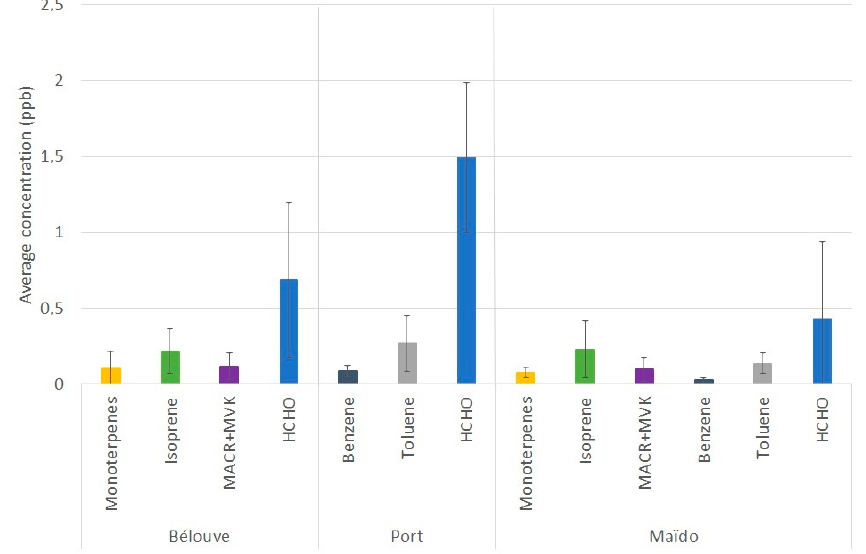
Figure 3. Partitioning of the average concentrations of the main VOCs in ppbv (±1 σ ) measured in Bélouve forest (from 25 April to 2 May 2018) and Le Port (from 20 April 2018) with the Laboratoire des Sciences, du Climat et de l’Environnement (LSCE) PTR-MS and at the Maïdo observatory (from 7